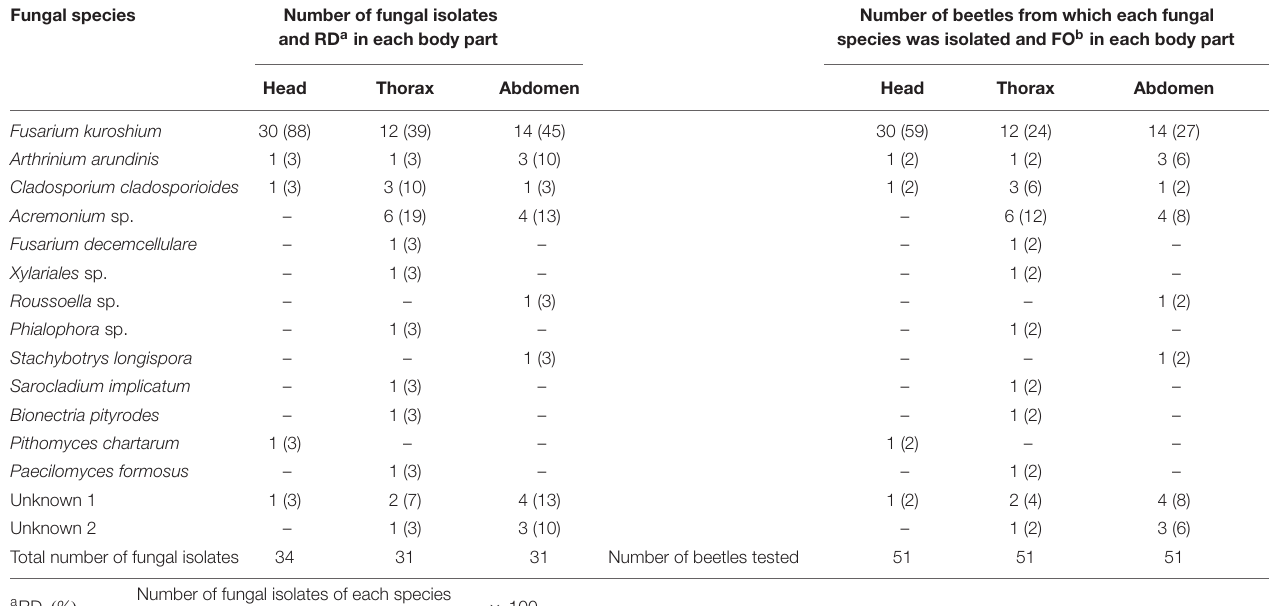
Number of beetles from which each fungal species was isolated and FO b in each body part